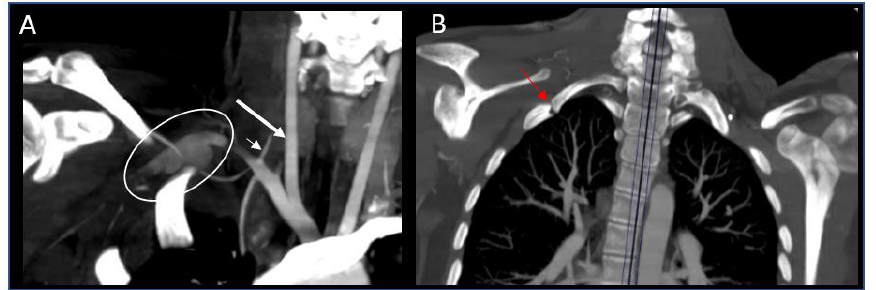
Figure 2. Computed tomography angiography of chest. ( A ) Right subclavian aneurysm (white circle) with lack of downstream intraluminal contrast compatible with thrombosis, presumed to have embolized to the right carotid artery (big arrow). Vertebral artery is patent (small arrow), coronal view. ( B ) Maximum intensity projection in bone windows highlighting abnormally fused right first and second ribs (white arrow), coronal view.